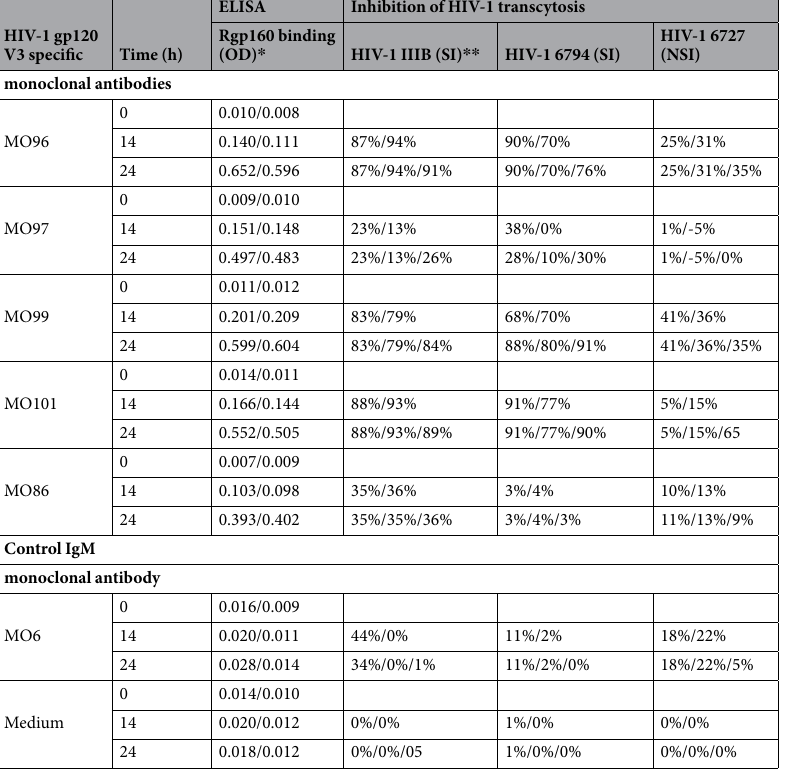
Table 1. Kinetics of IgM Mab-binding to recombinant gp160 and inhibition of HIV-1 transcytosisacross Caco- 2-IgR + cells. * Apical transwell culture medium collected and tested for anti-gp160 IgM binding activity at 0–24 hours by ELISA. ** Inhibition of HIV-1 p24 gag antigen in the basolateral transwell culture medium in the presence of anti-gp120 V3 Mabs compared with wells with control IgM or without